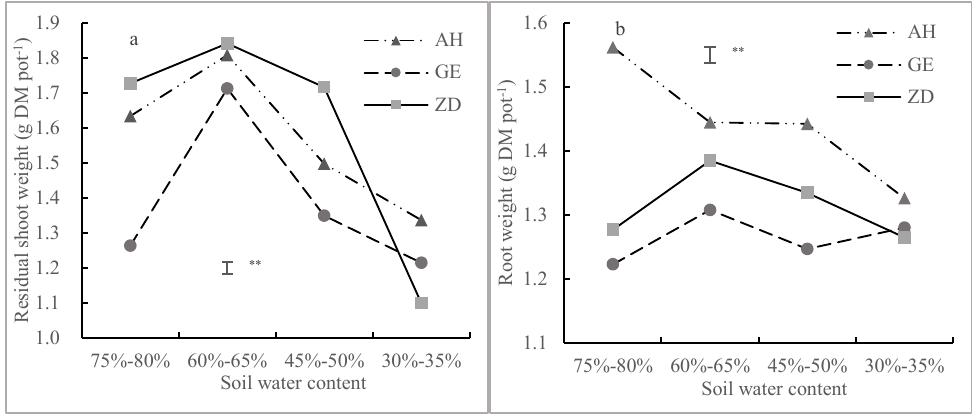
Figure 4. Interaction between soil water content (75 – 80%, 60 – 65%, 45 – 50%, and 30 – 35% of water- holding capacity) and cultivars (AH: Aohan; GE: Golden Empress; ZD: Zhaodong) on ( a ) residual shoot weight and ( b ) root weight of alfalfa. ** p < 0.01.